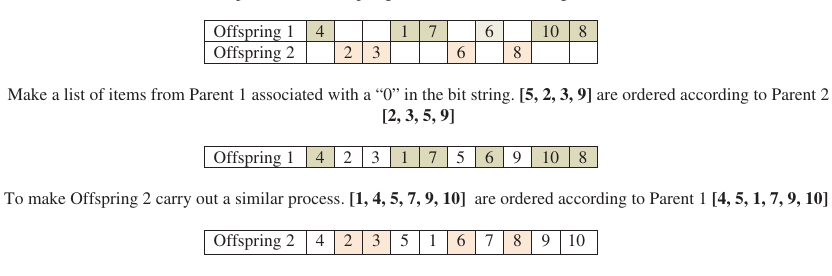
Figure 4: Uniform Order-Based Crossover.